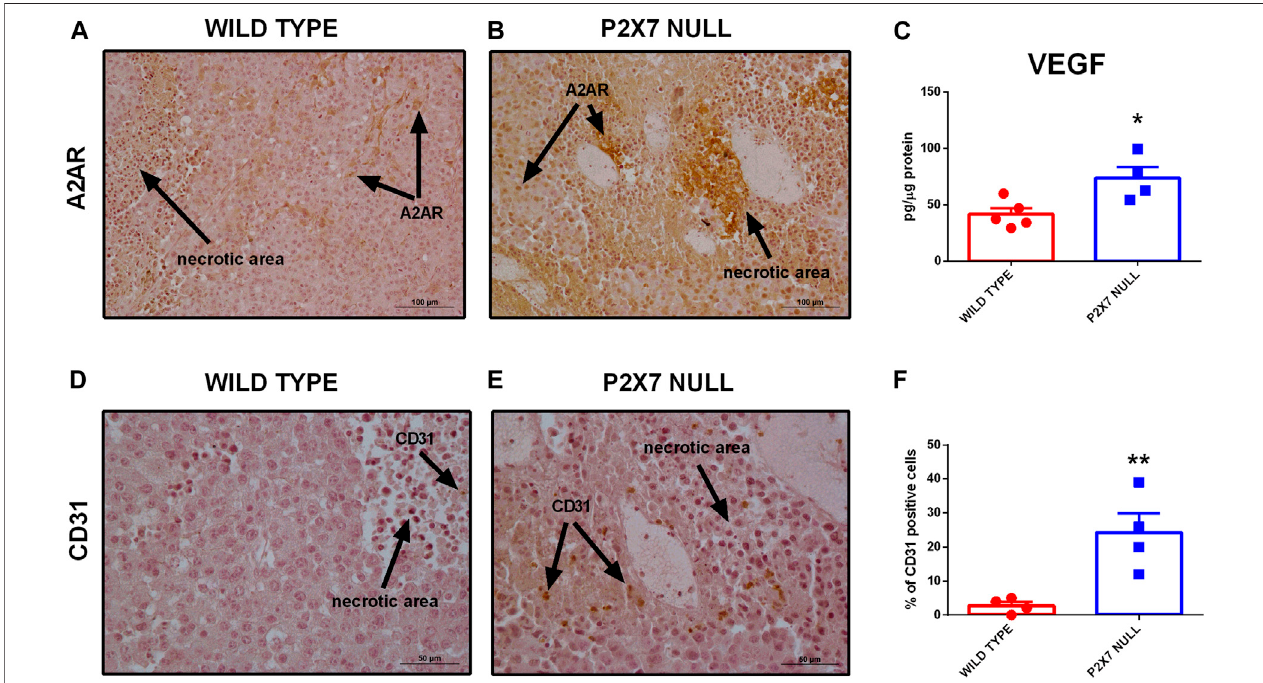
FIGURE3|(A,B) Immunohistochemistry ofA2ARintumorsderivedfrom wildtype (A) and P2X7null (B) C57bl/6 mice.Picturesareobtainedwitha20Xobjective. (C) Intra-tumorlevelsofVEGF(wildtype n =5,P2X7null n =4). (D – F) Immunohistochemistry (D,E) andrelativequanti fi cation (F) ofCD31intumorderivedfromwildtype and P2X7 null C57bl/6 mice ( n = 4 per group). Data are shown as the mean ± SEM. * p < 0.05 and ** p <